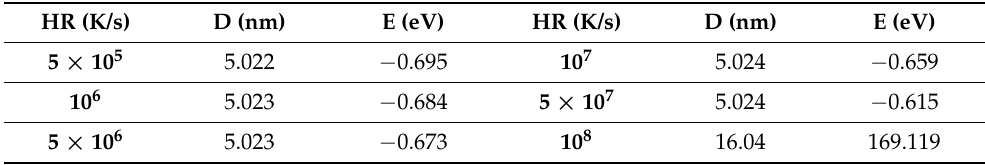
Figure 2. The shape ( a1 – a6 ), CNs ( b1 – b6 ), and RDF ( c1 – c6 ) of ANPs of Ni 5324 with different HRs. Table 2. D and E values for ANPs of Ni 5324 with different HRs.